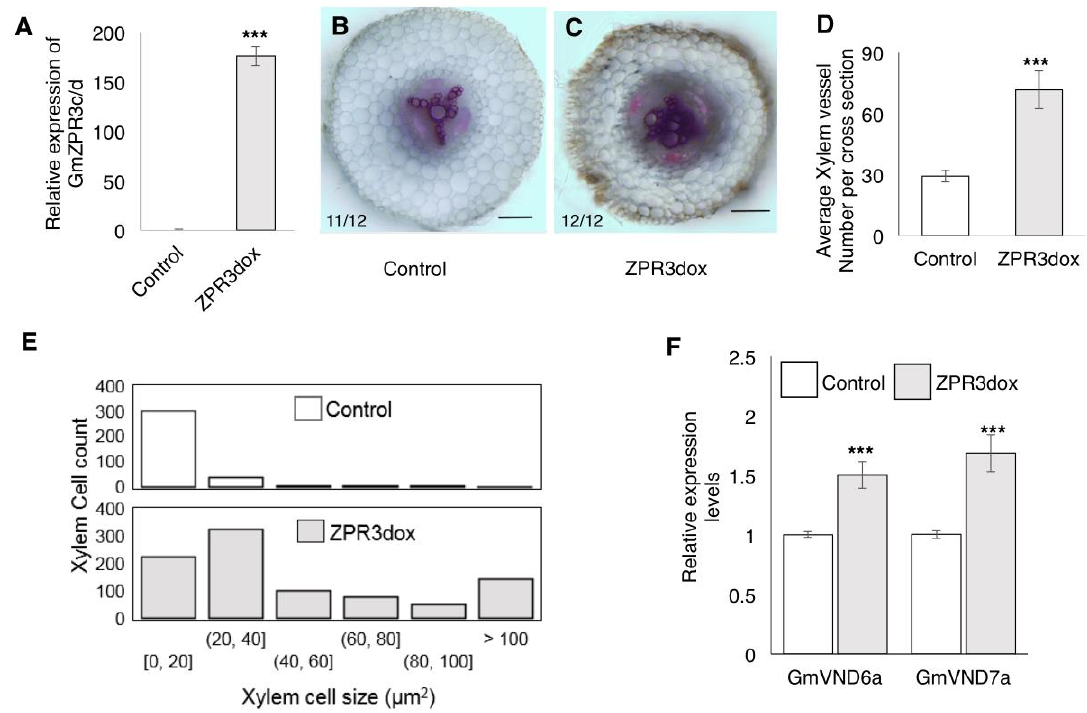
Figure 6. Ectopic xylem development in ZPR3d-overexpressing soybean roots. ( A ) Relative expression levels of ZPR3c/d in CsVMV:ZPR3d over expression roots (ZPR3dox) compared to vector control roots (fold change), assayed by RT-qPCR. Data shown are average of three independent biological replicates. Error bars indicate SE. *** P < 0.001, Student’s t -test. ( B , C ) Transverse sections of ( B ) vector control, and ( C ) ZPR3dox roots above the first emerged lateral root stained with phloroglucinol. The number of independent transgenic root sections showing the representative pattern out of the total number evaluated are indicated. Scale bars are 200 µ m. ( D ) Number of xylem cells in each transverse section of vector control and ZPR3dox roots above the first emerged lateral root. Data shown are average of 12 transverse sections per construct each from an independent root ( n = 12 roots/construct) and error bars indicate SE. *** P < 0.001, Student’s t -test. ( E ) Distribution of xylem cell sizes in transverse sections of vector control and ZPR3dox roots above the first emerged lateral root measured using imageJ. Data shown are from 351 cells for vector control and 860 cells for ZPR3dox measured in 12 transverse sections each from an independent root for each construct. ( F ) Relative expression levels of GmVND6a and GmVND7a in ZPR3dox roots compared to vector control (fold change), assayed by RT-qPCR. Data shown are average of three independent biological replicates. Error bars indicate SE. *** P < 0.001, Student’s t -test.